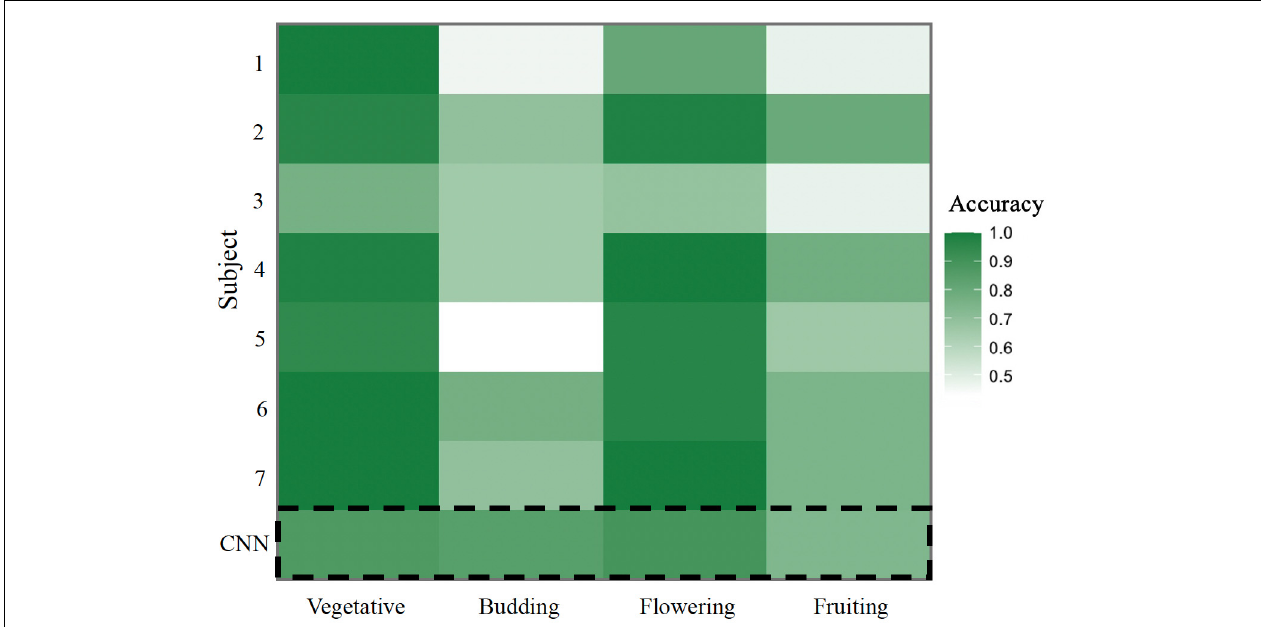
FIGURE 3 | Heat map comparing non-expert human accuracy to CNN accuracy in annotating a dataset of 241 A. petiolata iNaturalist images. Accuracy was calculated as the percent of correctly annotated images in each phenophase. Each row represents the accuracy of a non-expert individual, with the exception of the bottom row (dashed line box) which represents the accuracy of the CNN.